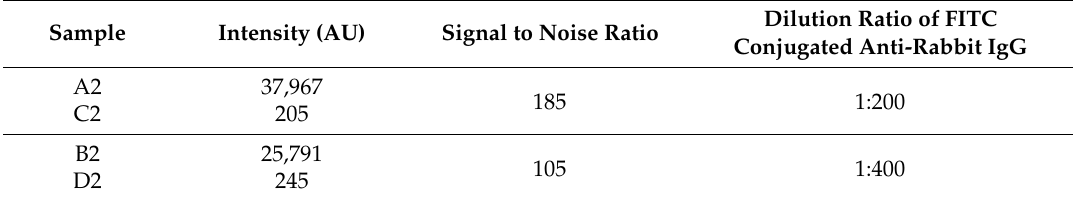
Figure 8. Comparison of presence of FITC on the surface of sample chip A2, B2 and control chip C2, D2: ( A ) FITC distribution on chip A2; ( B ) FITC distribution on chip B2; ( C ) FITC distribution on chip C2; ( D ) FITC distribution on chip D2. Scale bar stands for 2 µ m. Table 2. Mean optical intensity of FITC on the surface of sample chip A2, B2 and control chip C2, D2.